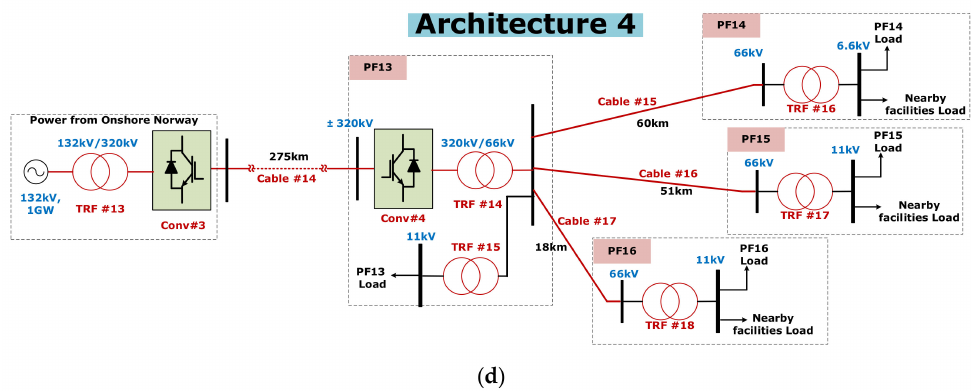
Figure 5. Proposed power architectures: ( a ) Architecture 1, ( b ) Architecture 2, ( c ) Architecture 3 and ( d ) Architecture 4.